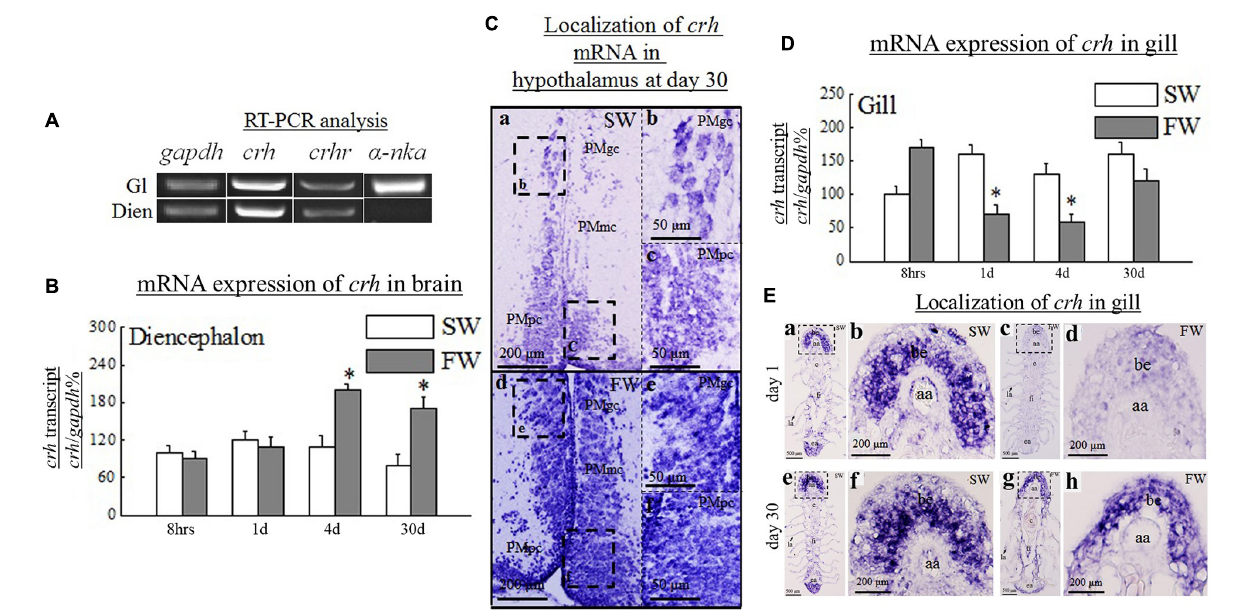
FIGURE 1 | (A) The black porgy corticotropin releasing hormone ( crh ), crh receptor ( crhr ), and a- nka cDNA consisted of 363 bp, 556 bp, and 968 bp. A single band of the expected size was obtained for crh, crhr, and α -nka mRNA in the tissue analyzed by RT-PCR. crh and crhr mRNA were detected in the diencephalon (Dien) and gill. a - nka mRNA was strongly detected in the gill. In Dien, the intensity of the band was very weak. The gapdh was used as an internal control. (B) Comparative analysis of crh , gene expressions as determined by quantitative real-time PCR in Dien of black porgy from a seawater (SW) to freshwater (FW) transfer at 8 h, day 1, day 4, and day 30. Each data had 10 fish. (C) Localization of crh in the hypothalamus gigantocellular (PMgc) (b,e) and parvocellular part of the magnocellular preoptic nucleus (PMpc) (c,f) was performed by in situ hybridization during SW (a–c) and FW (d–f) acclimation of black porgy on day 30. The representative fish is shown from one of 3 fish. There was no notable signal found in the representative sense pictures (not shown). PMgc, gigantocellular part of the magnocellular preoptic nucleus; PMmc, magnocellular part of the magnocellular preoptic nucleus; PMpc, parvocellular part of the magnocellular preoptic nucleus. (D) Comparative analysis of crh , gene expressions as determined by quantitative real-time PCR in gill of black porgy from SW to FW at 8 h, day 1, day 4, and day 30. Data (10 fish for each data) are expressed as means ± standard error of the mean. Student’s t test was conducted to determine significant differences ( p < 0.05) between SW and FW fish are denoted by asterisks ( ∗ ). (E) The in situ hybridization was performed to localize crh transcripts in black porgy gill during SW and FW acclimation at day 1 (c,d) and day 30 (g,h) . The transcripts of crh hybridization signal were weak in FW acclimated fish (c,d) in the branchial epithelium when compared to the SW acclimated fish (a,b) at day 1. And, the hybridization signals of crh were similar between SW (e,f) and FW (g,h) fish at day 30 in the branchial epithelium of the gill. The representative fish is shown from one of 3 fish. There was no notable signal found in the representative sense pictures (not shown). aa, afferent artery; be, branchial epithelium; ea, efferent artery; fi, filament; la,